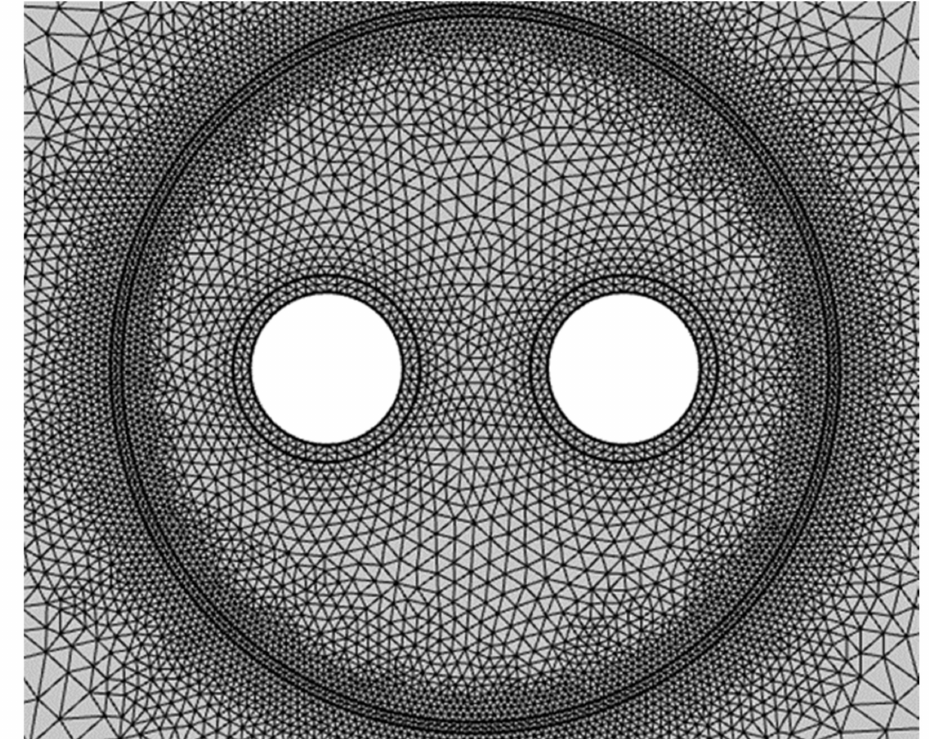
Figure 3. Particular of the mesh employed in the stationary simulations performed to estimate k g